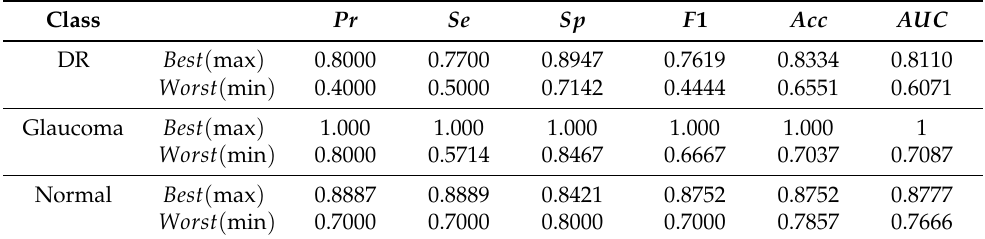
Table 8. The best and the worst classification results for the HRF dataset.